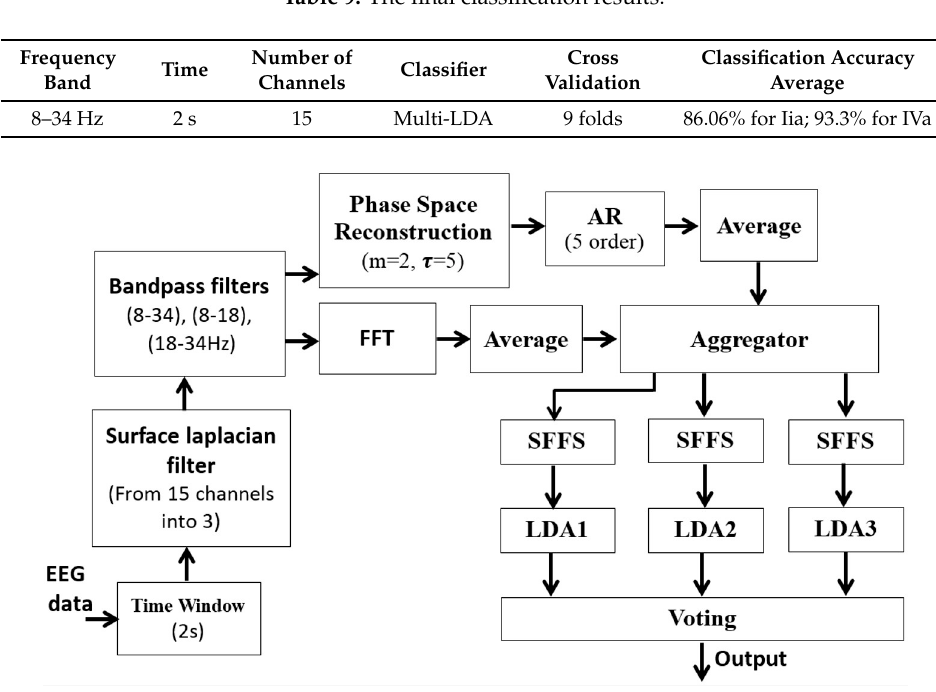
Figure 4. The best approach of three-class BCI system.